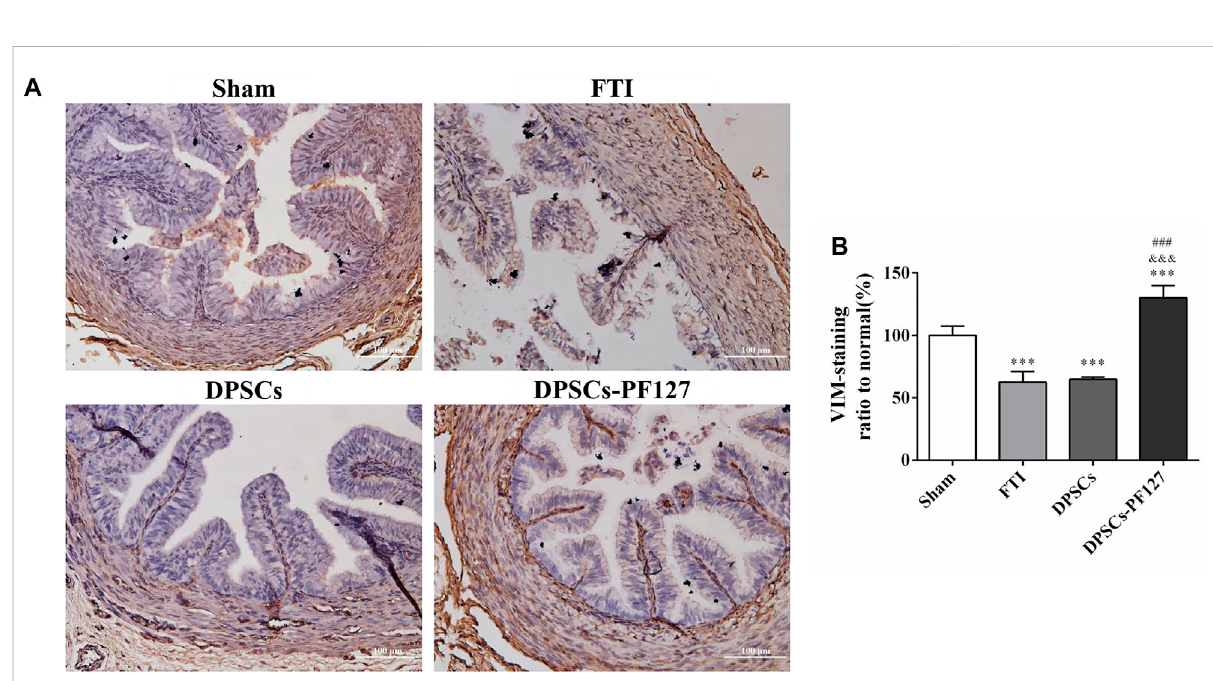
FIGURE 9 The immunohistochemisty assay of the FT at 4 weeks after injury. (A) Representative images of VIM from immunohistochemisty. Scale bar: 100 µm. (B) Quanti fi cation of the VIM positive staining ratio to normal in FT. The quanti fi cation results obtained by ImageJ. All data represent Mean values ±SEM. *** p < .001 versus the Sham group. &&& p < .001 versus the FTI group. ### p < .001 versus the DPSCs